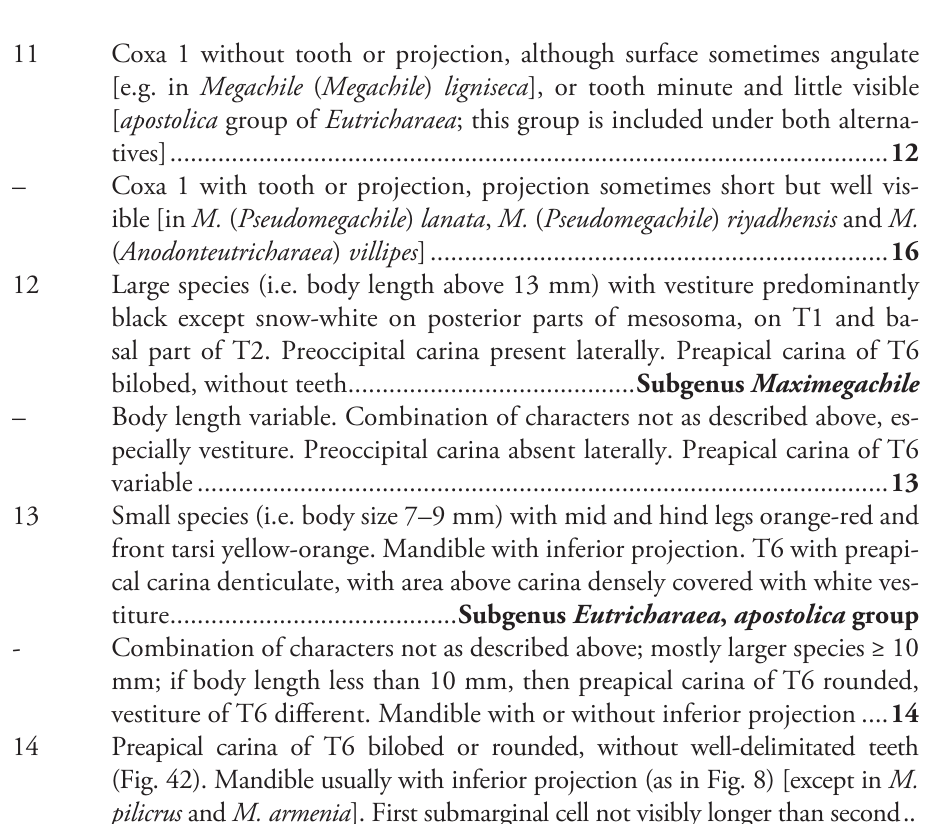
as deep as long, with conspicuous, complete cutting edge. Hind basitarsus comparatively broad, length approximately 2.2 times its maximal width (Fig. 29). Claw of hind leg with basal seta elongate, its length at least four times its basal width (Fig. 6) ..................................................... Subgenus Eurymella – Mandible less robust (Figs 2, 39, 41), tooth 1 usually not markedly larger than teeth 2–4 [except in M. deceptoria and a few other species (Fig. 40)]; mandible apically with tufts of orange hairs in the grooves below and above the outer ridge near the base of tooth 1 (Figs 2, 39, 41) [except in M. decepto- ria and a few other species (Fig. 40)]; third interspace longer than deep, usu- ally with cutting edge little-visible (Fig. 39). Hind basitarsus comparatively elongate (Fig. 28), length more than 2.5 times its maximal width [except in M. marginata ]. Claw of hind leg with basal seta modified to a short, thick process (Fig. 5) ....................................................... Subgenus Eutricharaea